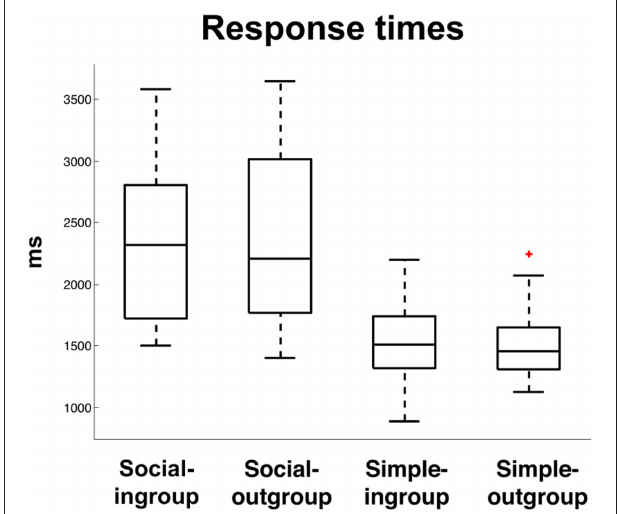
FIGURE 2 | Response times (ms) to Social Truth-Ingroup, Social Truth-Outgroup, Simple Truth-Ingroup, Simple Truth-Outgroup. The “ + ” indicates a single outlier with respect to the upper quartile of the